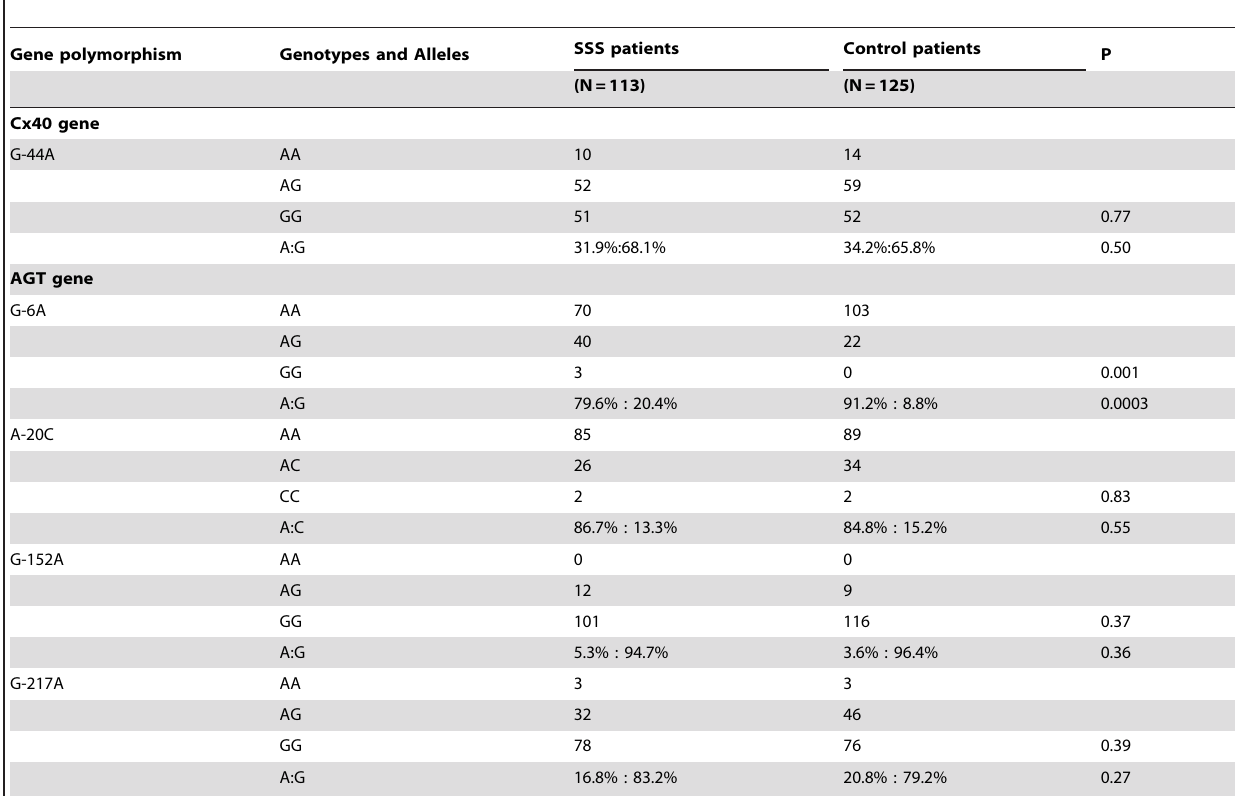
Table 3. Distribution of genotypes and alleles of Cx40 and AGT in patients with and without sick sinus syndrome. Gene polymorphism